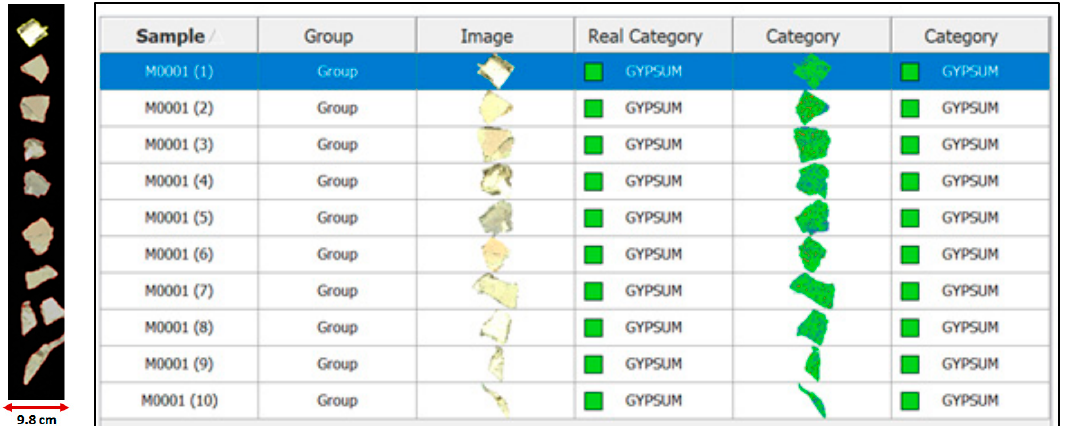
8.34 wt% (230) contaminants. An example of a validation trial is shown in Figure 5 and